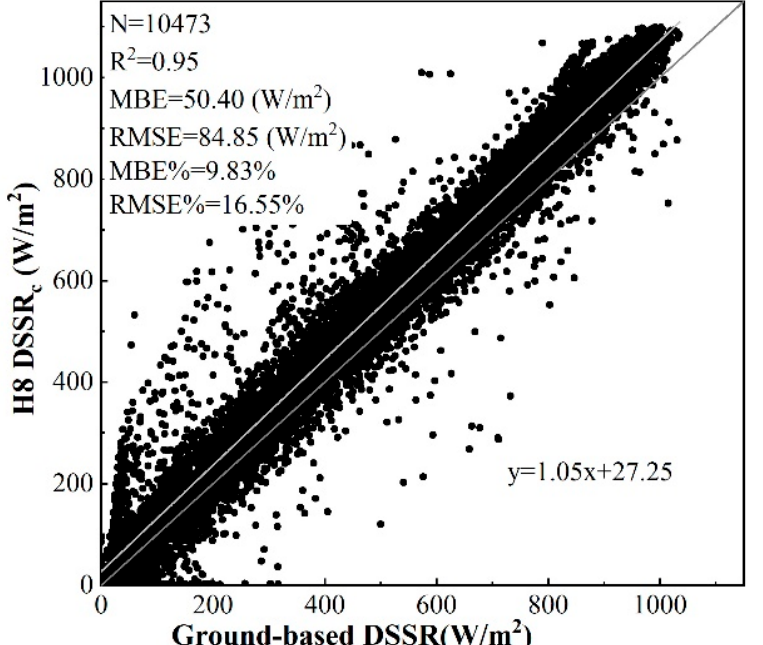
Figure 3. Scatterplots of the original H8 10-min DSSR products vs. the corresponding ground-based measurements in the UM-HRB. measurements in the UM-HRB.